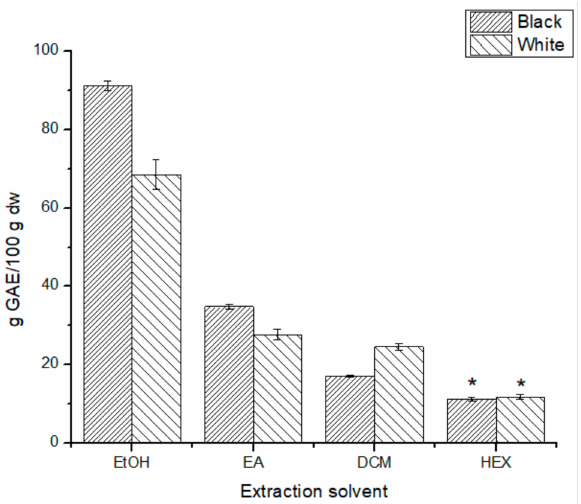
Figure 5. Total phenolic content for all extracts tested. * No significant difference ( p > 0.05). As for the global extractions, the TPC for B-SPLE was 2.0 ± 0.1 mg GAE/100 g dw and 1.71 ± 0.06 mg GAE/100 g dw for the W-SPLE, much lower than the ethanolic extracts. Regarding the caffeic acid content (Figure 6), despite the extract concentration injected (5000 mg L − 1 ), the analytical signal was lower than the limit of detection in the calibration curve for the DCM extracts. Additionally, while there was no significant difference between extracts with the same type of solvent (B-EtOH and W-EtOH, for example), the difference between extracts done with different extraction solvents was statically significant ( p < 0.05).